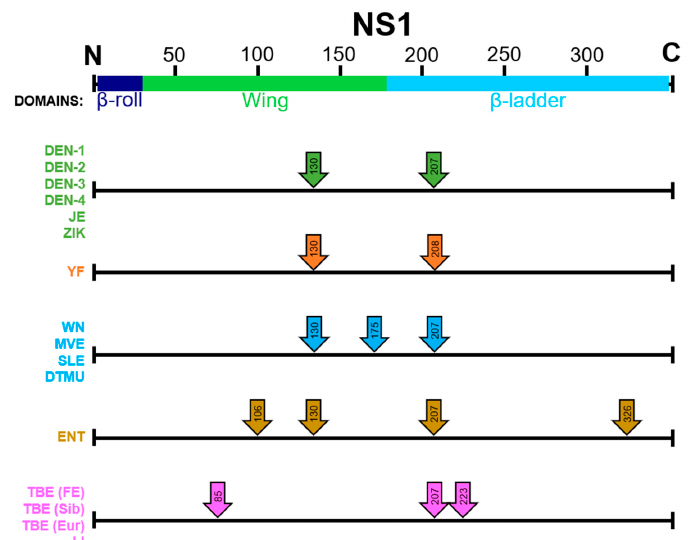
Figure 1. Location of putative or proven flavivirus N-linked glycosylation sites in the NS1 protein. DEN: dengue; JE: Japanese encephalitis; ZIK: Zika; YF: yellow fever; WN: West Nile; MVE: Murray Valley encephalitis; SLE: St. Louis encephalitis; ENT: Entebbe bat; TBE: tick-borne encephalitis; FE: Far East; Sib: Siberian; Eur: European; LI: louping ill; DTMU: duck Tembusu.